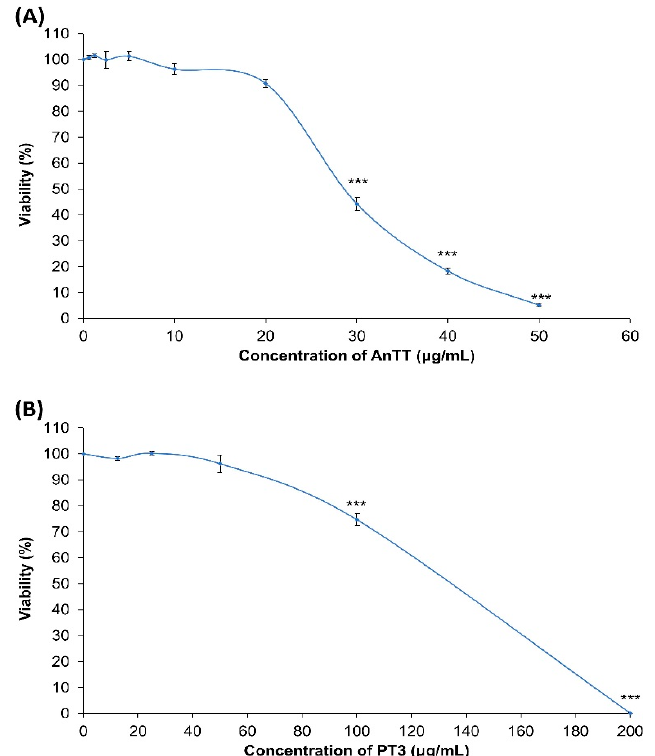
Figure 1. The cytotoxicity of AnTT ( A ) and PT3 ( B ) on SW1353 chondrocytes upon 24 h treatment. The results were obtained from 3 independent experiments with 4 technical replicates during meas- urement. The data were displayed in mean ± SEM. *** indicates a significant difference ( p < 0.001) compared to the VC (0 µg/mL).